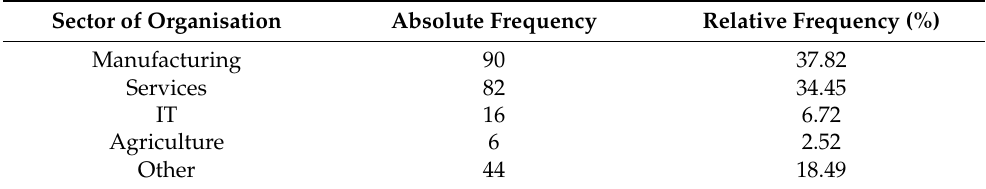
Table 1. Distribution of the respondents, according to the sectors of the organisations (own elabora- tion,